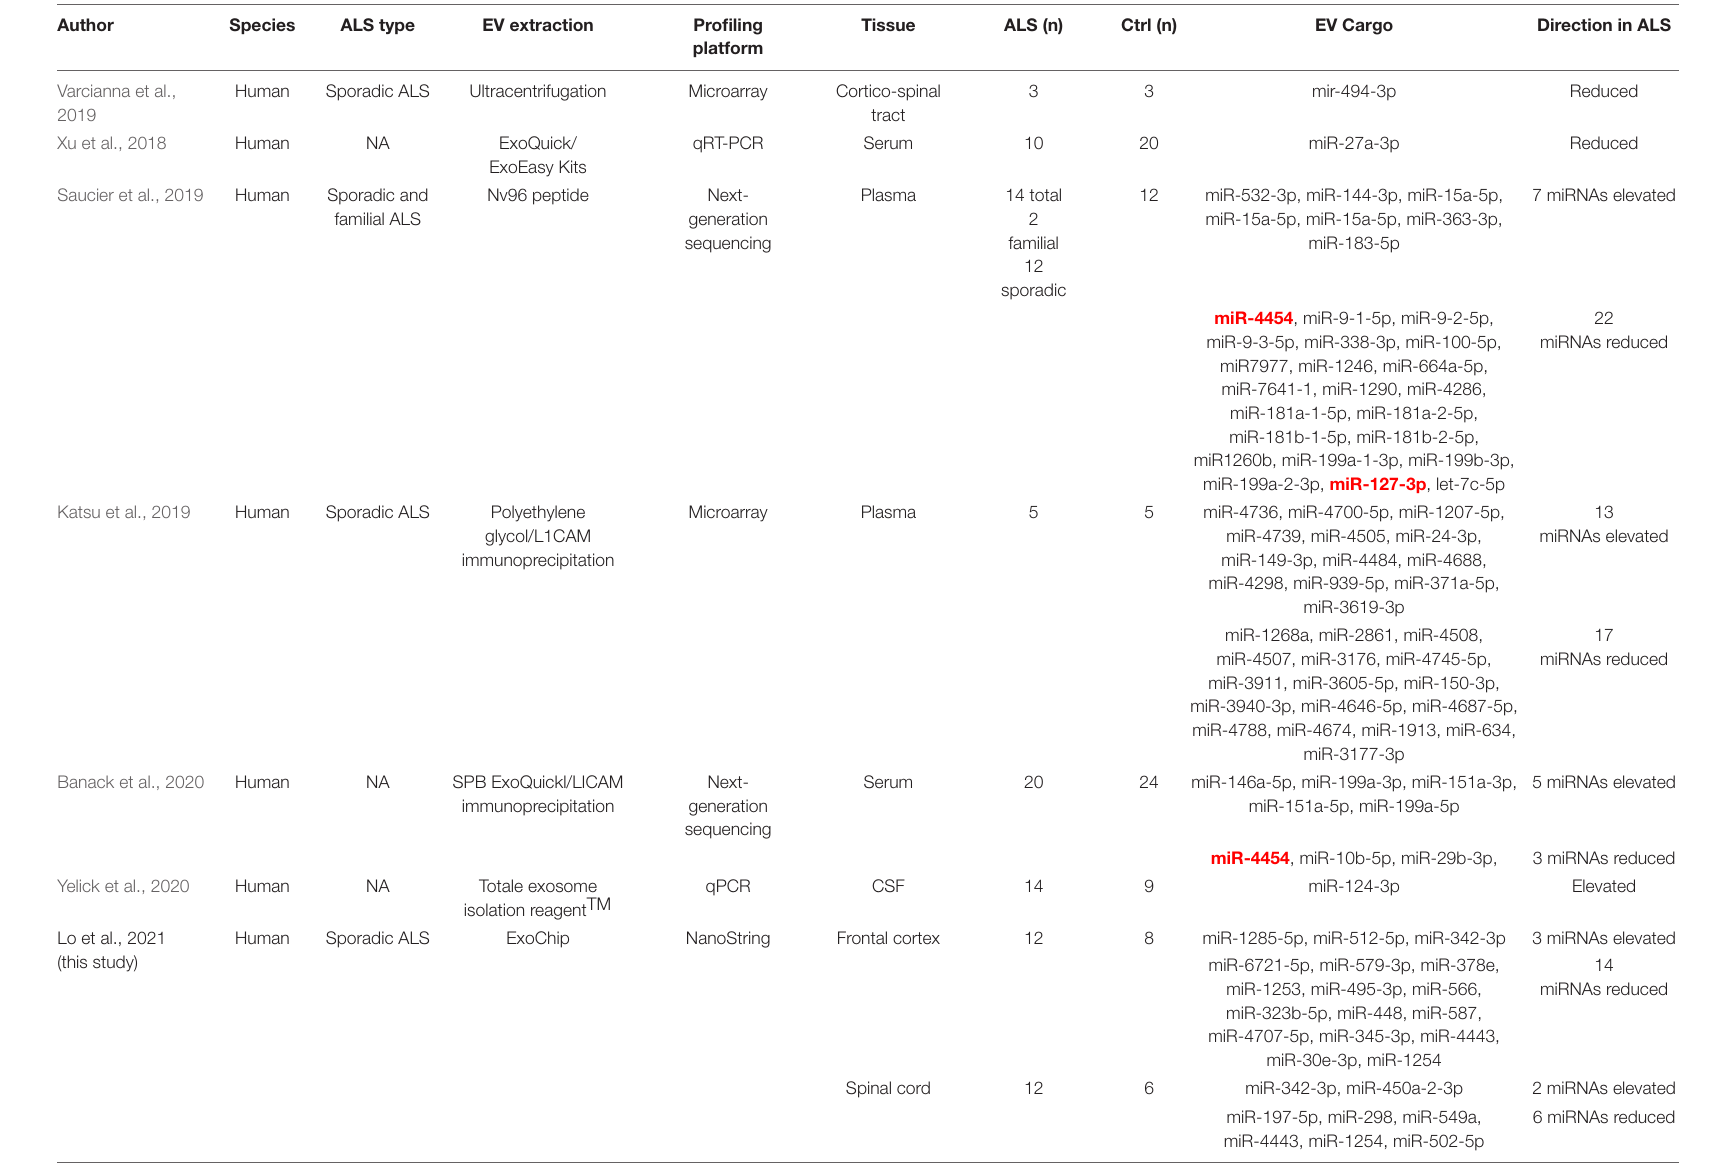
TABLE 3 | Studies reporting dysregulated EV miRNAs in ALS. Extracellular vesicle characterization in sporadic